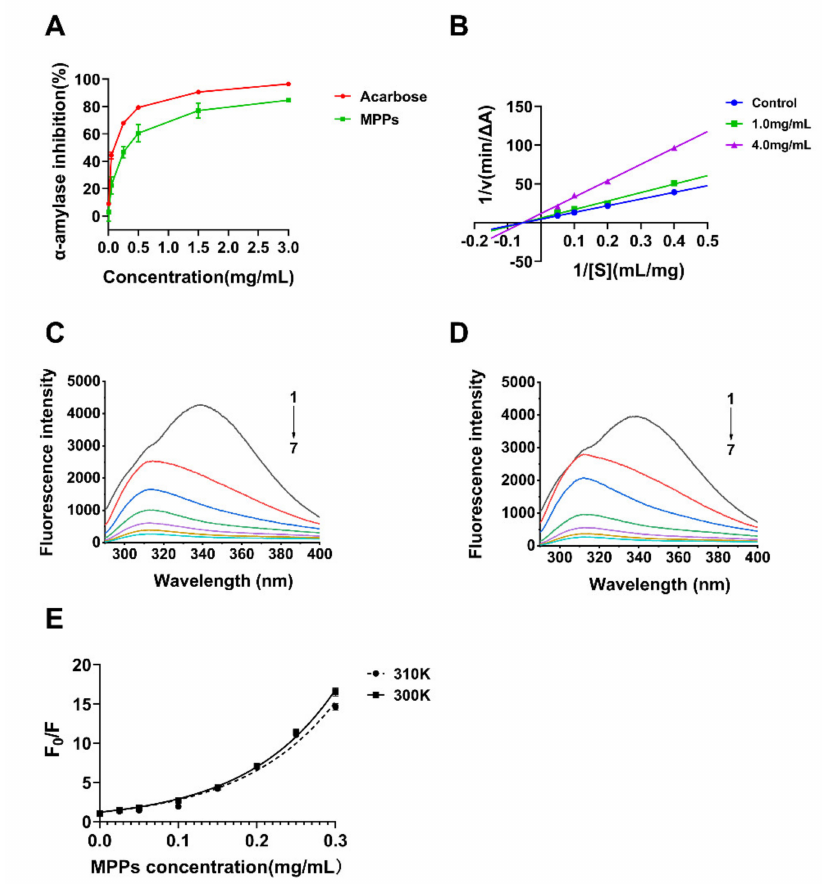
Figure 2. Inhibition of α -amylase by MPPs in vitro: ( A ) Inhibitory effect of MPPs on the α -amylase activity; ( B ) Lineweaver-Burk plots of MPPs on α -amylase; ( C , D ) fluorescence spectra of α -amylase with various amounts of MPPs, (C) T = 300 K and (D) T = 310 K. [ α -amylase] = 0.50 mg/mL; [MPPs] = 0 mg/mL (1), 0.05 mg/mL (2), 0.10 mg/mL (3), 0.15 mg/mL (4), 0.20 mg/mL (5), 0.25 mg/mL (6), and 0.30 mg/mL (7), respectively; ( E ) The Stern-Volmer plots of α -amylase quenched by MPPs at different temperatures (300 K and 310